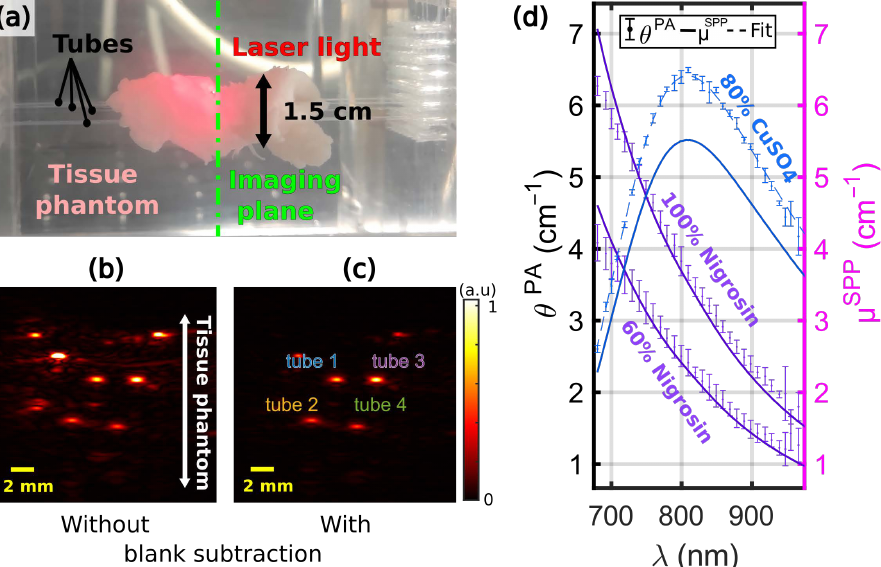
Figure A1. Performance of the calibration method with a tissue phantom. ( a ) Annotated picture of the tissue phantom. The tubes are surrounded by raw turkey breast. Three tissue layers (0.5 cm thick) form a tissue block with a total thickness of 1.5 cm: one layer above tubes 1/3, one layer between tubes 1/3 and tubes 2/4, and one layer below tubes 2/4. ( b , c ) PA images at 800 nm and with the tubes filled with the 100% solution of nigrosin. PA images ( b ) without and ( c ) with the subtraction of the blank acquisition (tubes filled with water) to the radio-frequency data before image reconstruction. ( b , c ) have the same color scale, which was set to correspond to the range of values in ( c ). ( d ) PA coefficients obtained for three solutions: the 100% and the 60% solutions of nigrosin (purple) and the 80% solution of CuSO 4 (blue). The solutions were measured twice in four tubes. The median ± MAD values of θ PA ( λ ) were displayed with dot markers and error bars. The absorption coefficient µ SPP ( λ ) is displayed with a solid line. The fit of µ SPP to (cid:101) θ PA is shown with a dashed line for the 80% solution of CuSO 4